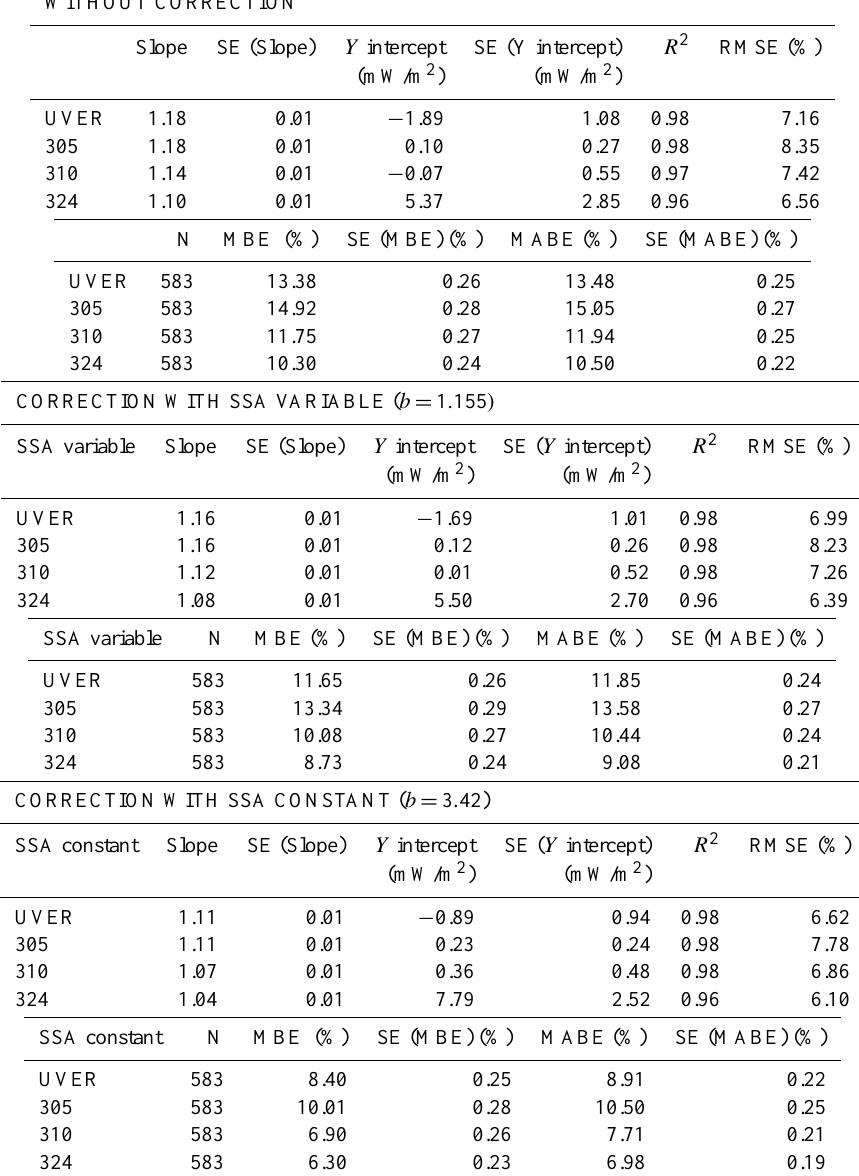
Table 2. Results of linear regression analysis between OMI and Brewer UV products without correction and the correction for the two approaches: SSA variable and SSA constant, and the statistical parameters of relative differences. The parameters are the following: the slope of the regression, the standard error (SE) of the slope, the Y intercept, the SE of the Y intercept, the correlation coefficient ( R 2 ) , the root mean square errors (RMSE), the number of data ( N ), the mean bias error (MBE), the standard error (SE) of the MBE, the mean absolute bias error (MABE), and the SE of the